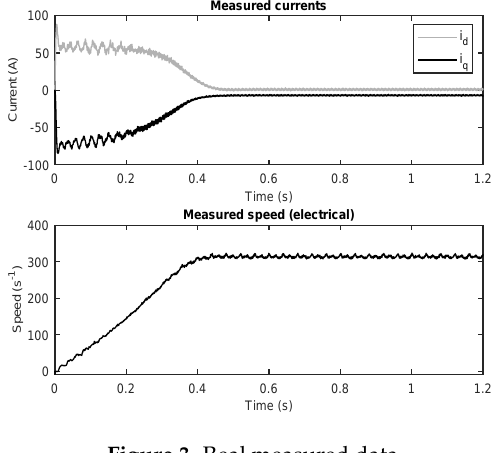
Figure 3. Real measured data.